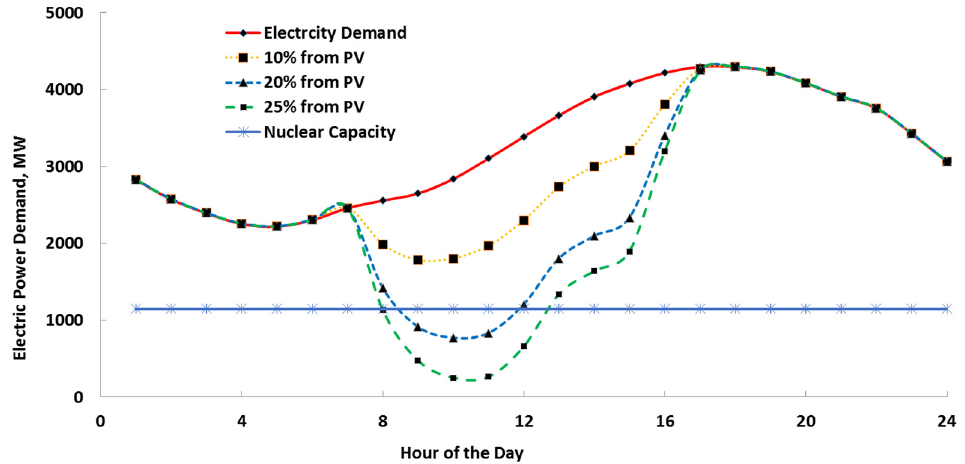
Figure 1. The duck curve resulting when the PV-generated electricity reached 10%, 20% and 25% of the annually generated electricity in the San Antonio, Texas region.